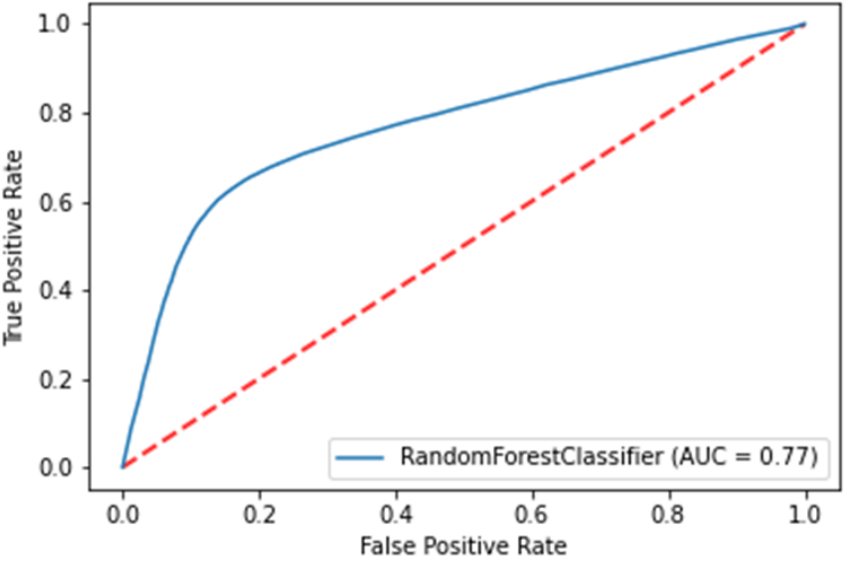
Figure 8. ROC curve for random forest (corresponds to models in which the feature extraction period is one day, while churn period is also one day).